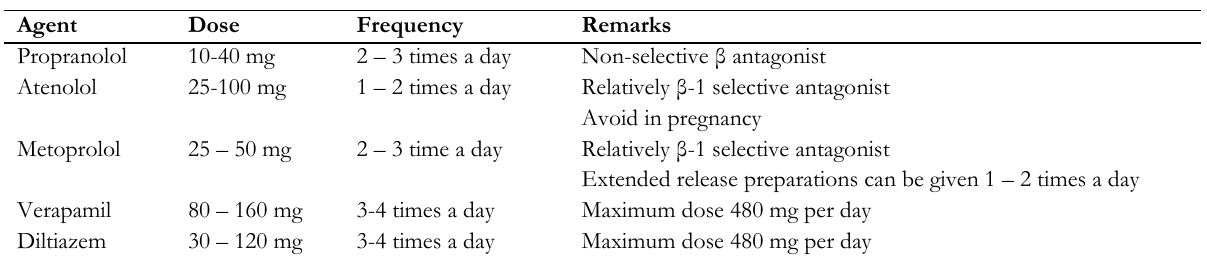
Table 3.6. Beta blockers and calcium channel blockers for treatment of symptomatic